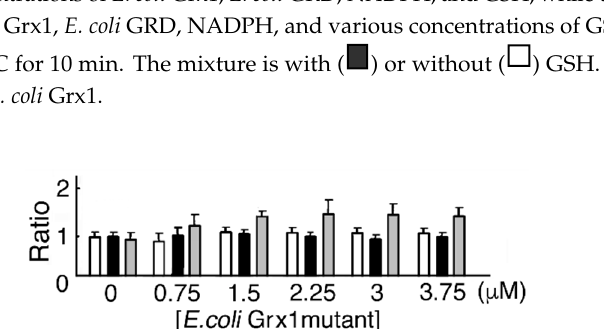
contains various concentrations of E. coli Grx1, E. coli GRD, NADPH, and GSH, while the other reducing